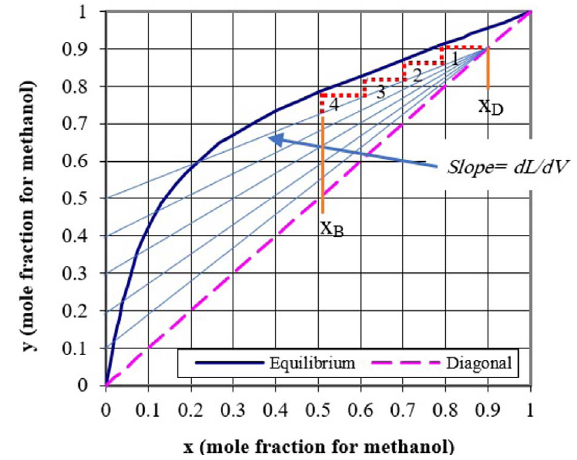
Fig. 1. Vapor – liquid equilibrium for a methanol – water system with the adapted operating line at constant concentration 0.9.